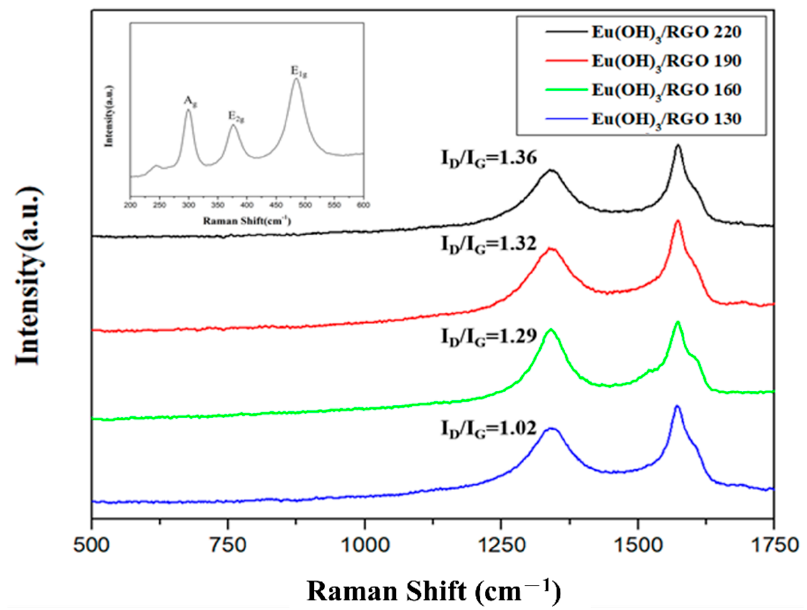
Figure 3. Raman spectra of the Eu(OH) 3 /RGO nanocomposites (inset shows the Raman spectrum of Eu(OH) 3 ) .